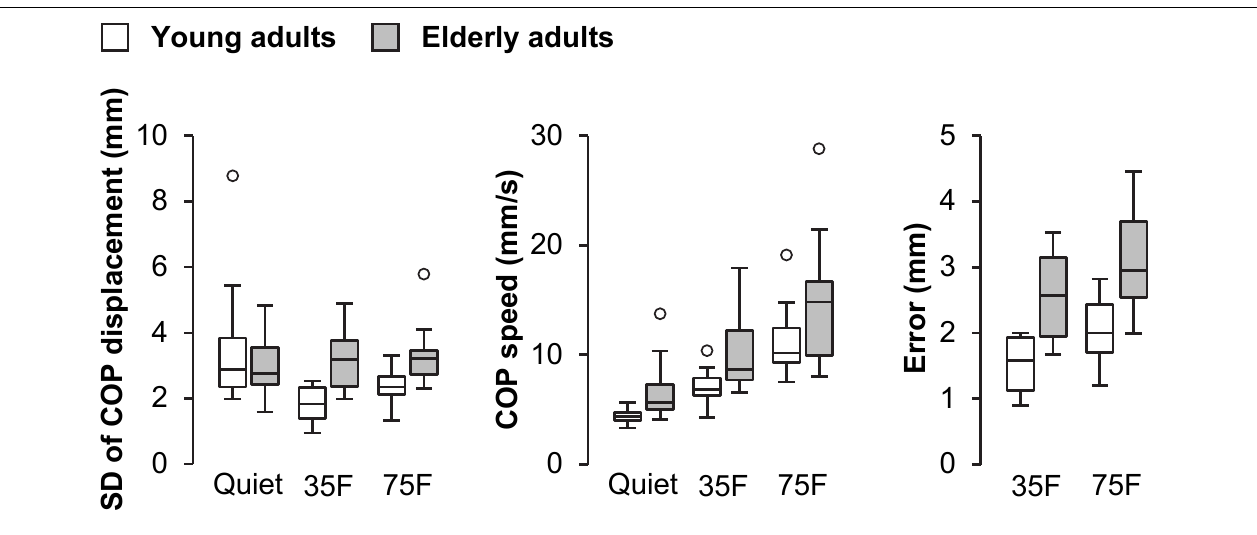
FIGURE 3 | Effects of task and age on COP parameters. Data for standard deviation (SD) of center of pressure (COP) displacement, mean COP speed, and error from target line were separately presented from left to right. Tasks were quiet standing (Quiet), 35% forward lean (35F), and 75% forward lean (75F). Small circles indicate